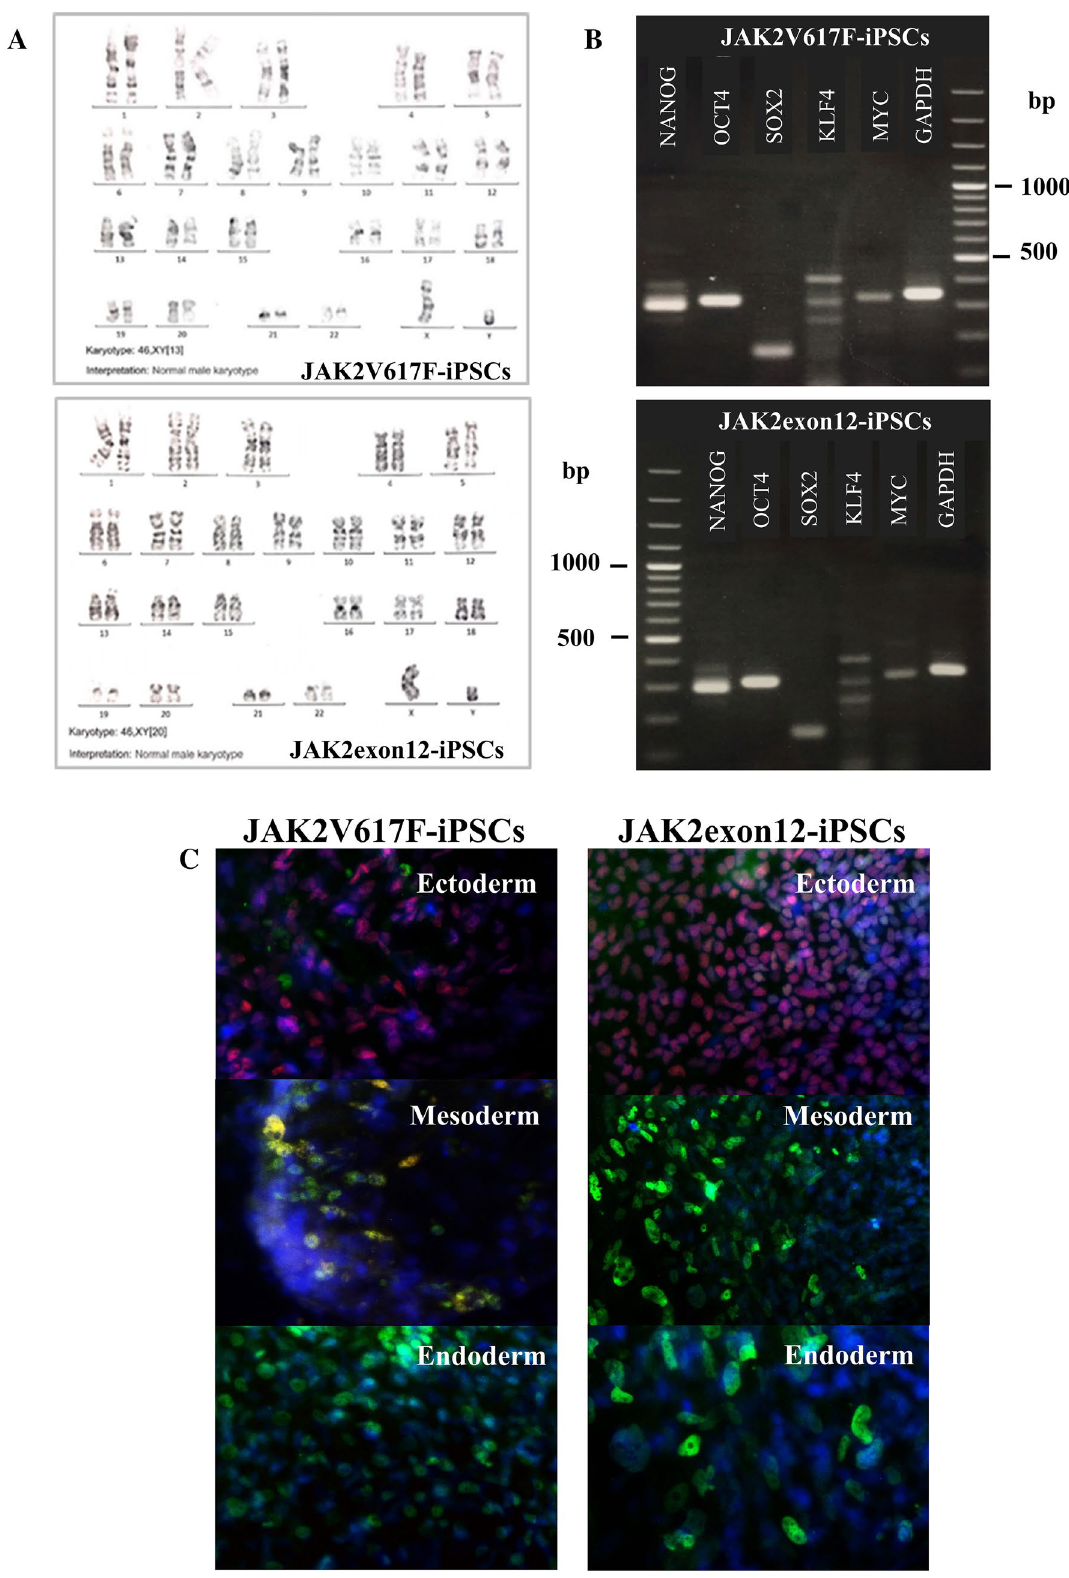
Figure 2. Characteristics of modified induced pluripotent stem cells (iPSCs). ( A ) Karyotyping of the genetically modified iPSCs: JAK2V617F-iPSCs and JAK2N542_E543del-iPSCs (JAK2exon12-iPSCs). ( B ) The expression of NANOG, OCT4, SOX2, KLF4 and MYC of JAK2V617F-iPSCs and JAK2exon12-iPSCs using reverse transcriptase polymerase chain reaction (RT-PCR). The full gels are presented in the Supplementary Fig. S1B. ( C ) Immunofluorescence of differentiated cells from JAK2V617F-iPSCs and JAK2exon12-iPSCs. Embryoid bodies were transferred onto 0.1% gelatin coverslips and cultured for 14 days for differentiation. Cells were stained with antibodies specific to ectoderm (red and green), mesoderm (green), endoderm (green) layers and DAPI (blue) for nuclei (×400 magnification). The images were captured by Axio Observer fluorescence